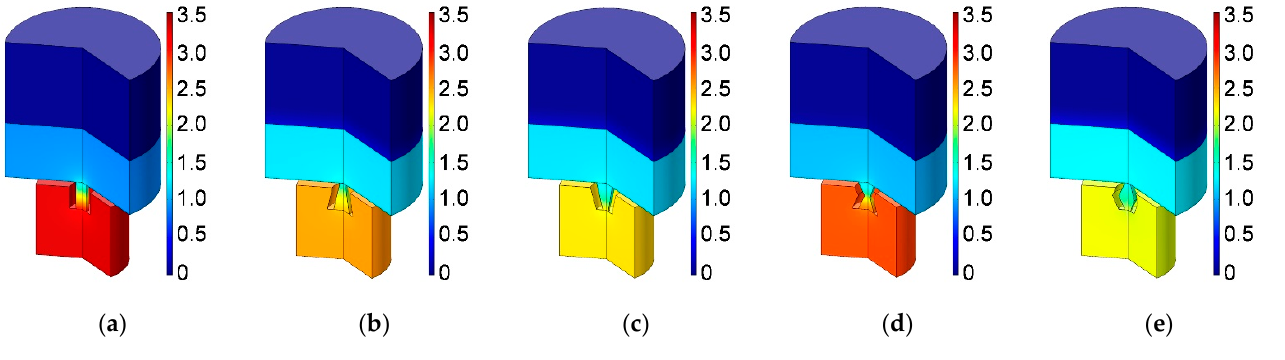
Figure 22. Distribution of acoustic pressure for the HR with aperture for various tangent sectional shapes. ( a ) Rectangle; ( b ) common trapeziform; ( c ) reverse trapeziform; ( d ) dumbbell; and ( e ) olive.